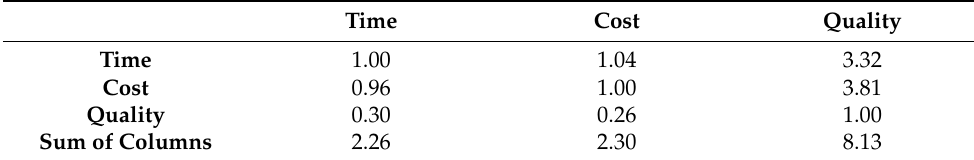
Table 7. Aggregated matrix.